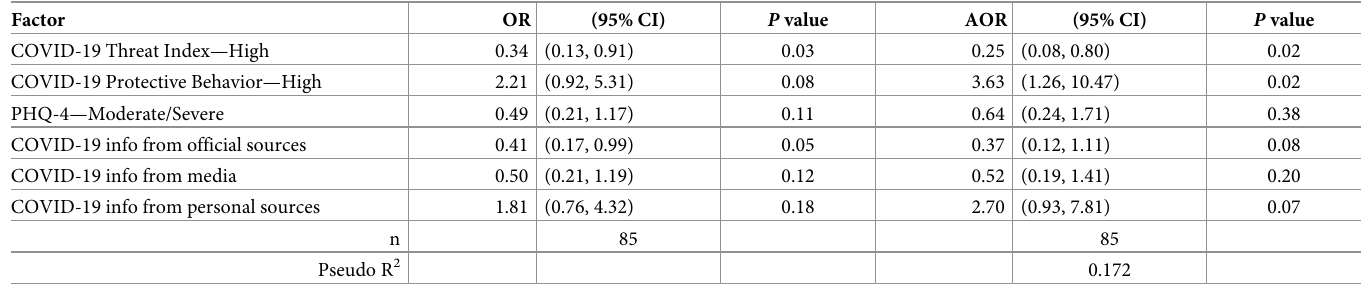
Table 2. Model of COVID-19 vaccine